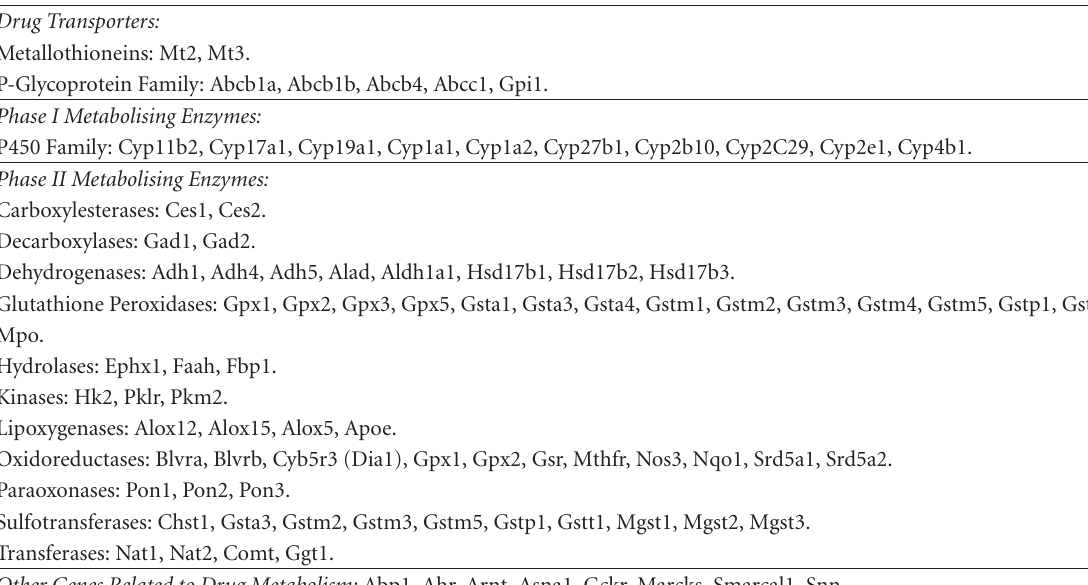
Table 1: A list of functional gene groupings included in the array assay.